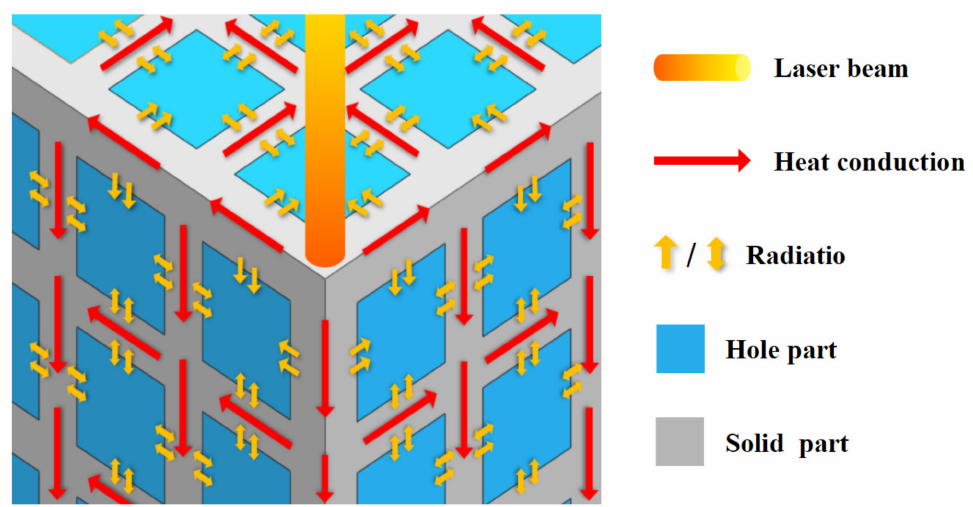
Figure 7. The transfer method of laser heat in porous